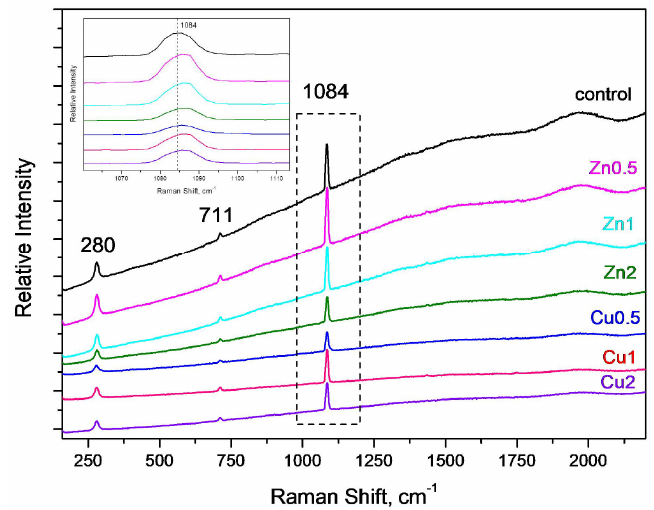
y a physical interaction occurred between NPs and IPs matrix [44].